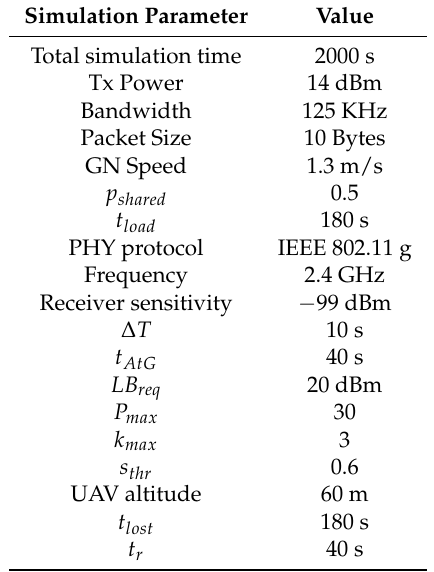
Table 2. Simulation parameters and their